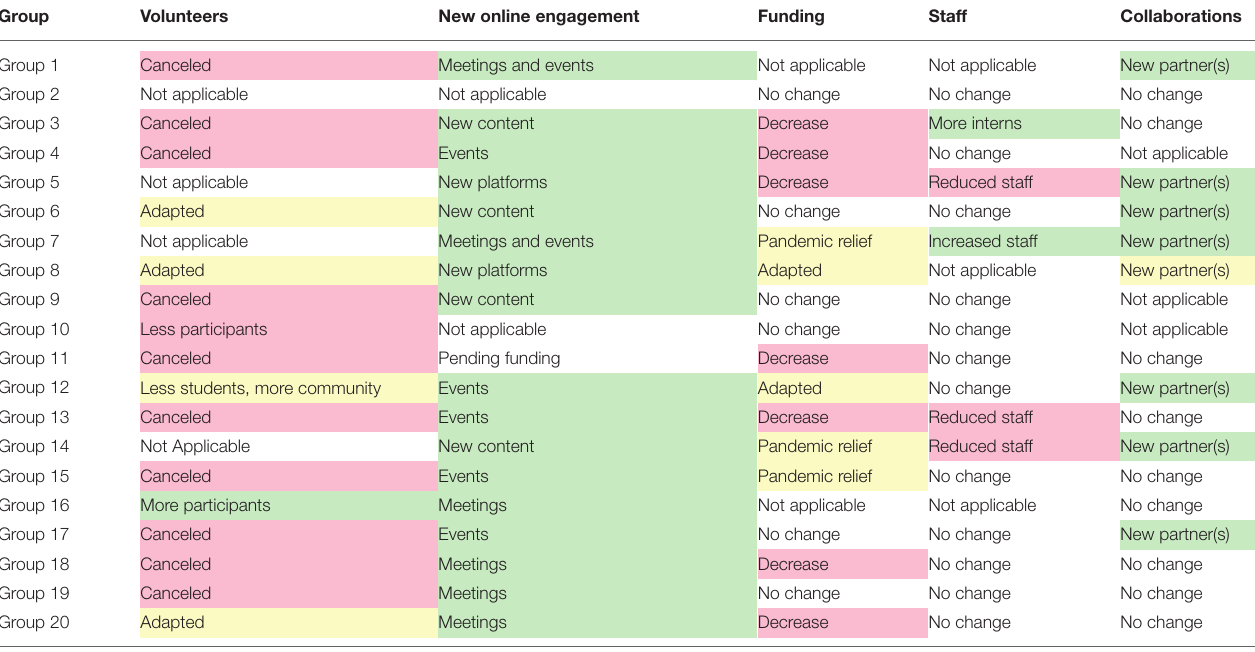
TABLE 2 | Impacts to ESGs as a result of the COVID-19 pandemic.